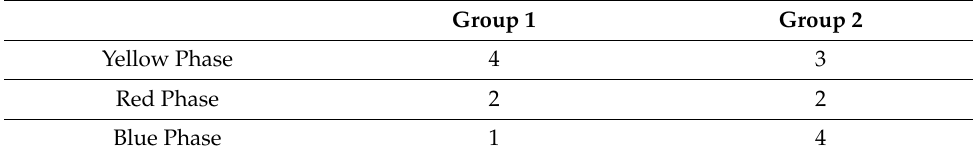
Table 2. Customers distribution.